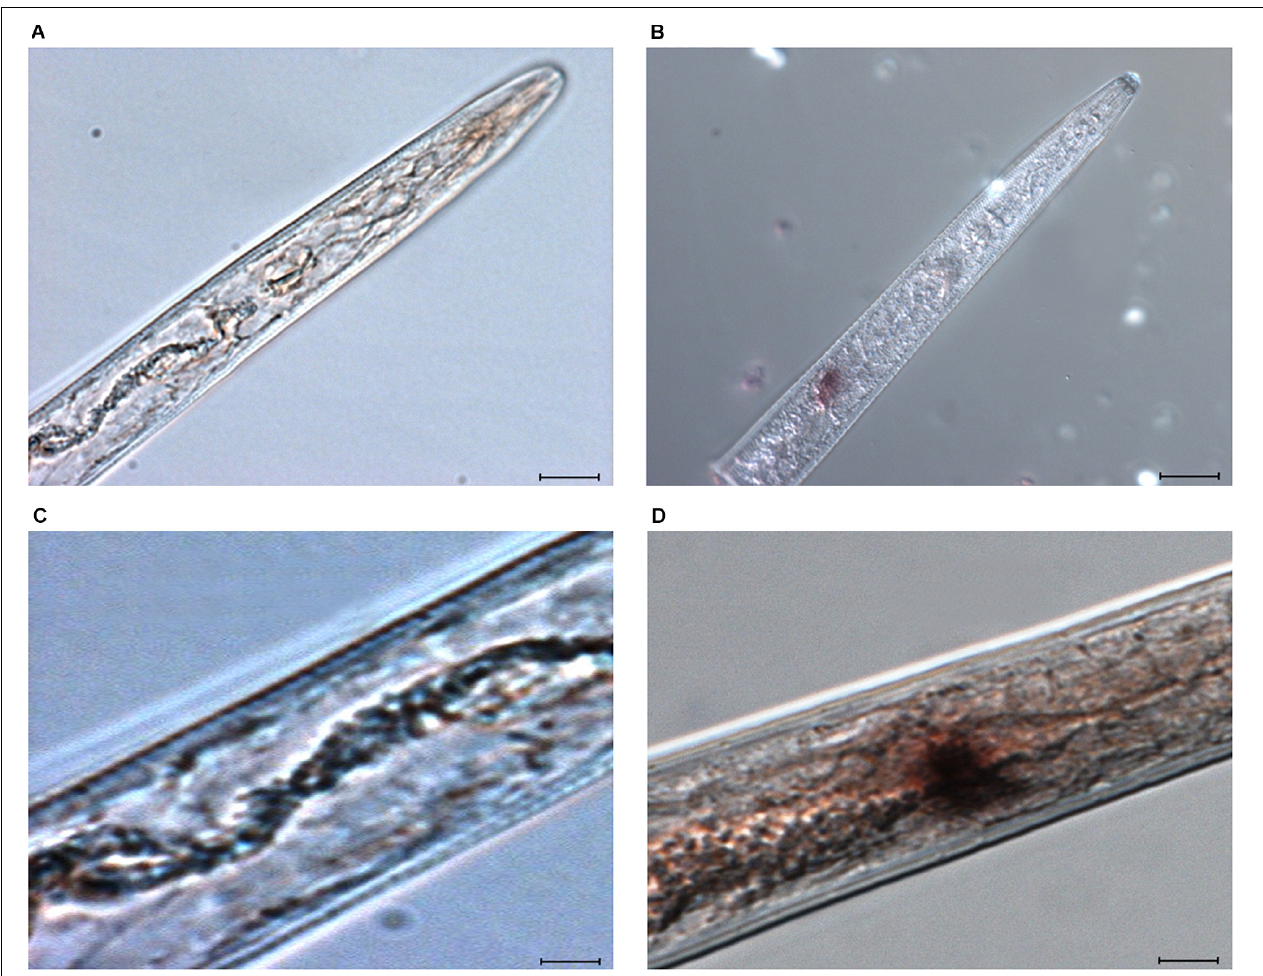
FIGURE 2 | In situ hybridisation of DIG-labeled cDNA of Mi-flp1 probe in the anterior of M. incognita J2s. (A,C) No hybridization signal in the control juveniles with DIG labeled sense probes, (B,D) Intense staining was observed in the nematode nerve ring region, revealing the Mi-flp1 gene expression in ventral pharyngeal nerves near to metacarpal bulb of the central nervous system. Mi-flp1 expression site is indicated by brown/black color due to the enzymatic breakdown of a chromogenic substrate by alkaline phosphatase conjugated to anti-DIG antibody. Scale bar = 10 and 20 µ m.